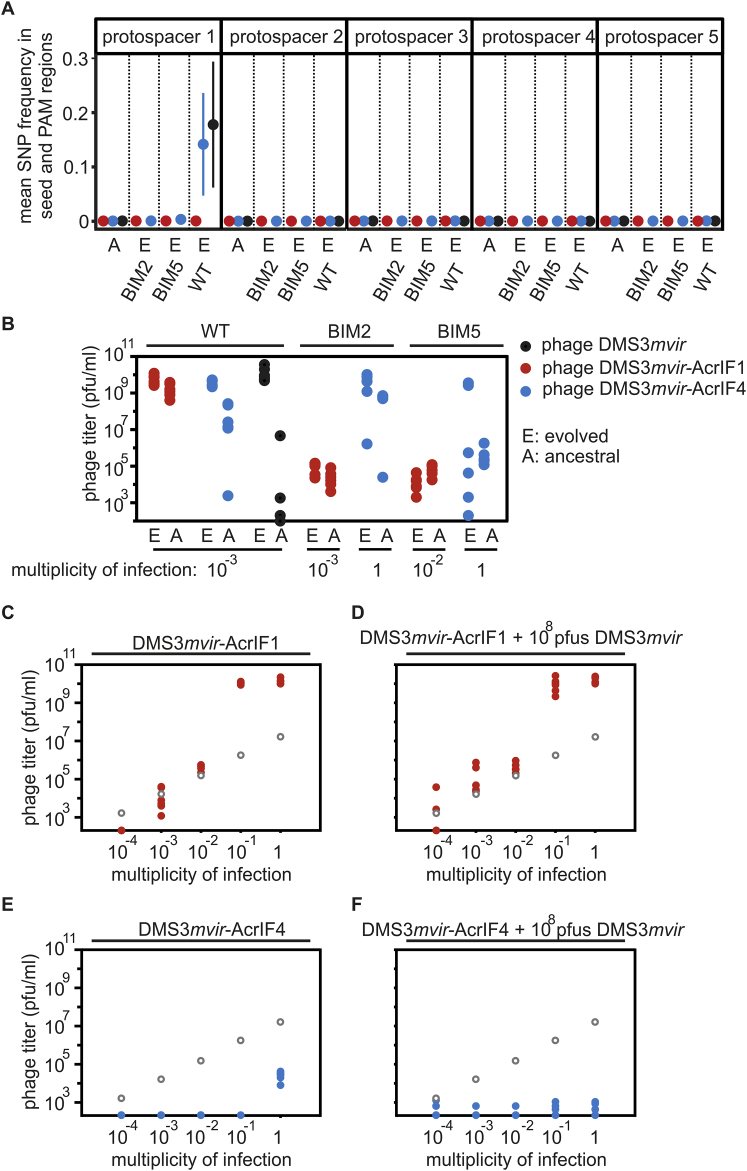
Epidemiological Tipping Points Cannot Be Explained by Phage Evolution or Csy Complex Sequestration, Related to Figure 2(A) Deep sequencing of protospacer sequences of phages DMS3mvir (black data points), DMS3mvir-AcrIF1 (red data points) or DMS3mvir-AcrIF4 (blue data points), either ancestral (A) or evolved on WT, BIM2 or BIM5 hosts (DMS3mvir only on WT). Protospacer 1 is targeted by WT, BIM2 and BIM5, protospacer 2 is targeted by BIM2 and BIM5, and protospacers 3, 4 and 5 are targeted by BIM5. Mean SNP frequency across the seed and PAM region (in total 10 nucleotides) of each protospacer is shown, error bars indicate the 95% c.i.(B) Density-dependent epidemiological tipping points are not due to phage evolution. Viral titers at 24 hpi of phage DMS3mvir (black data points), DMS3mvir-AcrIF1 (red data points) or DMS3mvir-AcrIF4 (blue data points) on bacteria PA14 WT, BIM2 or BIM5. Below each diagram is indicated which phage amounts (pfus) were added in the experiment. A indicates ancestral phage; E indicates evolved phage (isolated from the experiments depicted in Figure 2).(C) Viral titers at 24 hpi of BIM2 with 104, 105, 106, 107 or 108 pfus DMS3mvir-AcrIF1.(D) Viral titers at 24 hpi of BIM2 with 104, 105, 106, 107 or 108 pfus DMS3mvir-AcrIF1 in the presence of 108 pfus DMS3mvir.(E) Viral titers at 24 hpi of BIM2 with 104, 105, 106, 107 or 108 pfus DMS3mvir-AcrIF4.(F) Viral titers at 24 hpi of BIM2 with 104, 105, 106, 107 or 108 pfus DMS3mvir-AcrIF4 in the presence of 108 pfus DMS3mvir. Grey circles indicate the phage titers (pfu/ml) at the start of the experiment (corresponding to the addition of 104, 105, 106, 107 or 108 pfus). Colored points represent phage titers at 24 hpi; each data point represents an independent biological replicate (n = 6). The limit of detection is 200 pfu/ml.